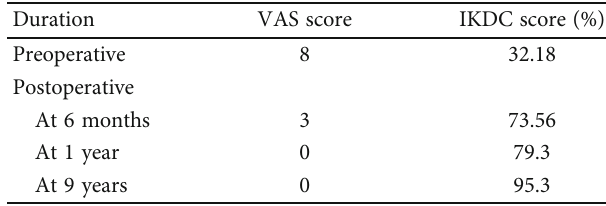
Table 2: Functional and radiological outcome